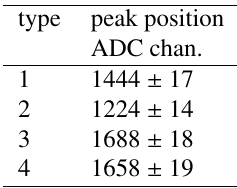
Table 2. Positions of the cosmic peaks for di ff erent types of the PMMA plates with the thickness of 8